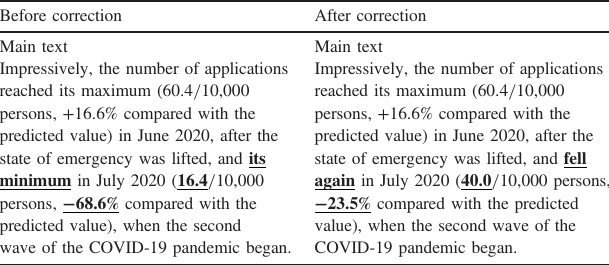
value revised. The solid line shows the regression line applied to the number of new February 2020. The dotted line shows the predicted values based on the regression. The